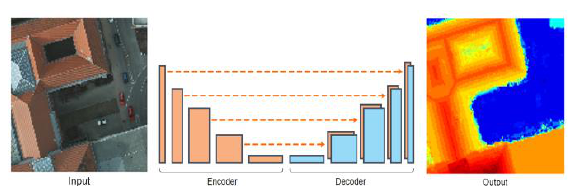
Figure 1 . Overview of the proposed network